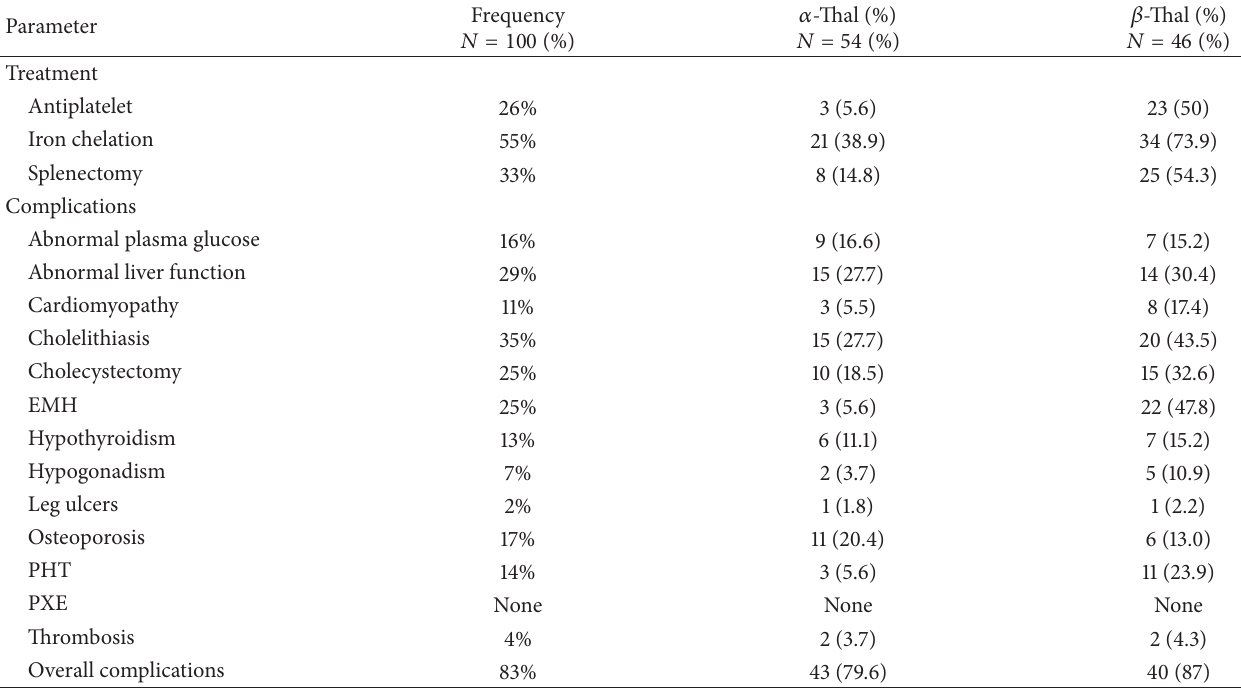
Table 3: Treatment, outcome, and complications in study population.